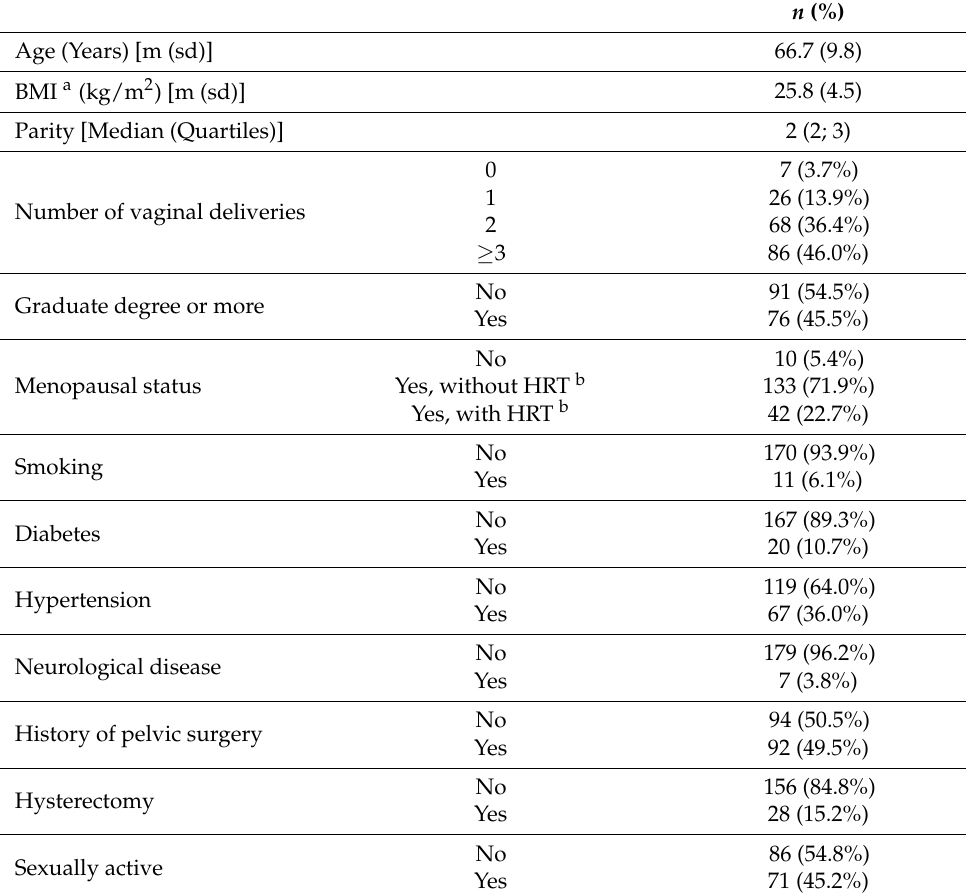
Table 1. Baseline characteristics of the population at